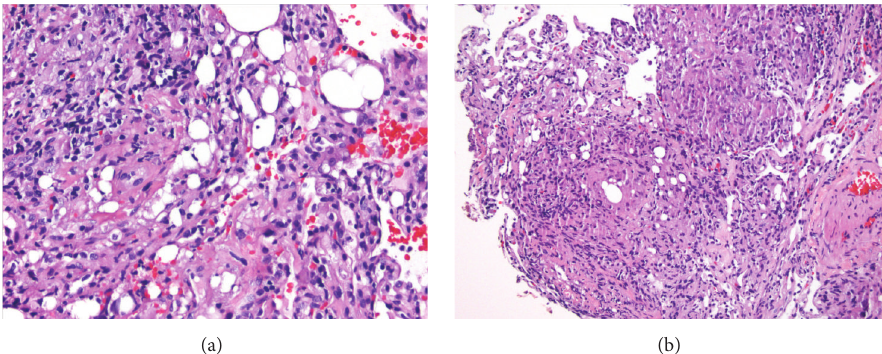
Figure 3: (a) Lung parenchyma with multiple vacuoles and dilated capillaries (40X). (b) Lung parenchyma with dilated capillaries and nonrefractile vacuole-like structures and histiocytic reaction